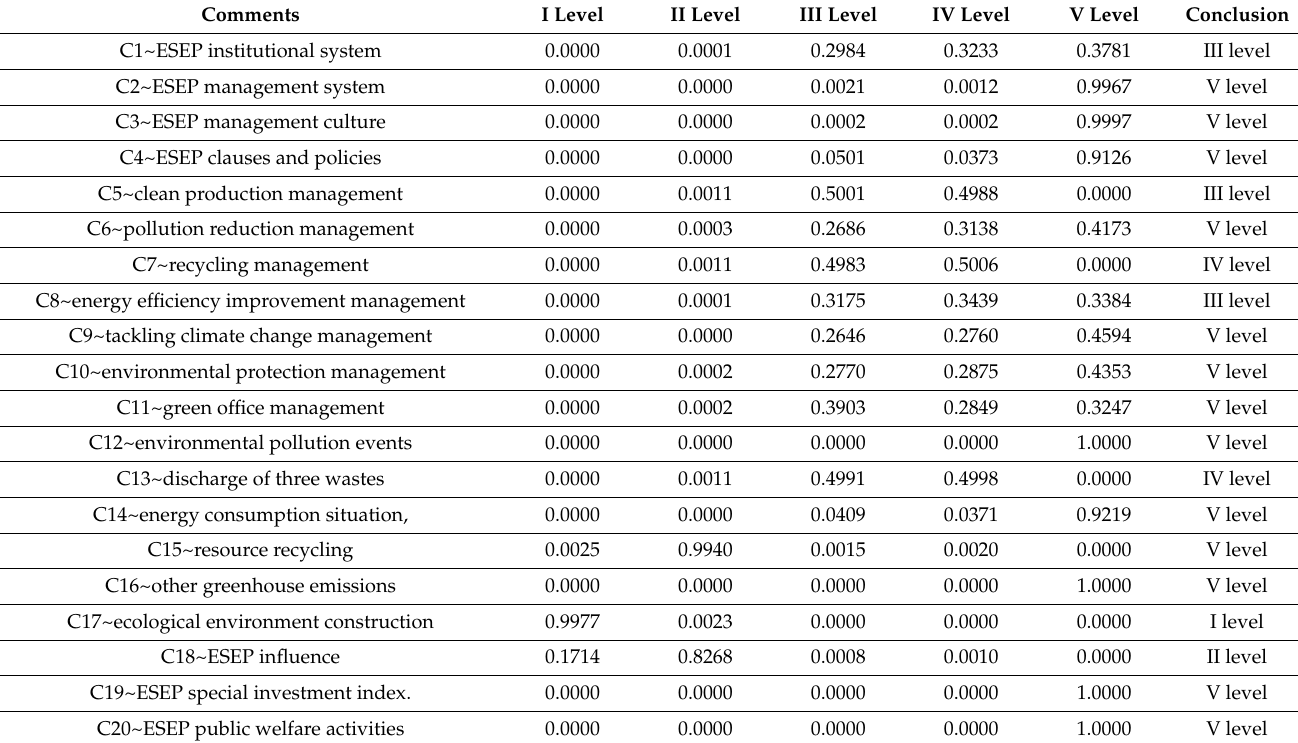
Table 4. Membership degree of each index of SINOPEC ESEP management in